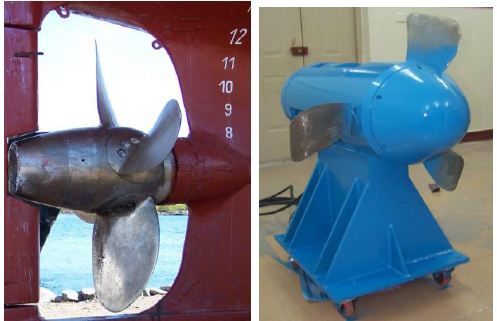
Figure 1. The actual CPP system ( left ) and its scale model ( right ). Processes 2020 , 8 , x FOR PEER REVIEW